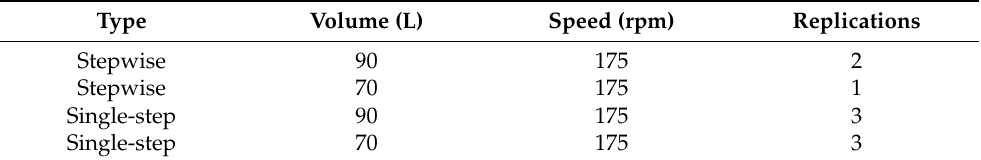
Table 2. Summary of stepwise and single-step dosing trials classified by volume, rotational speed and number of replications